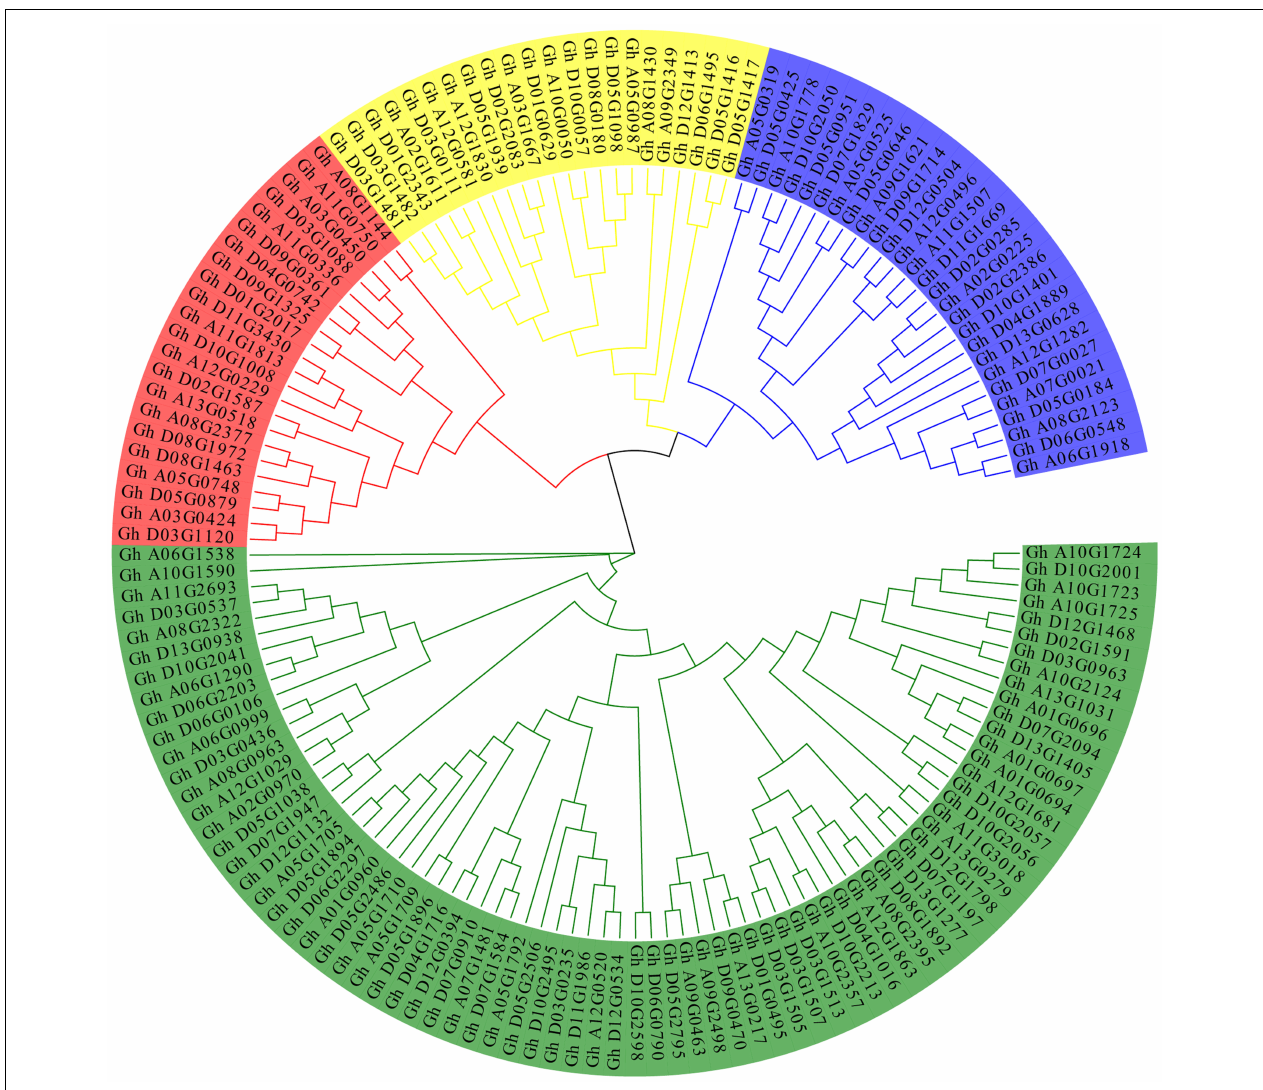
FIGURE 1 | Phylogenetic tree of the P450 family protein sequences in upland